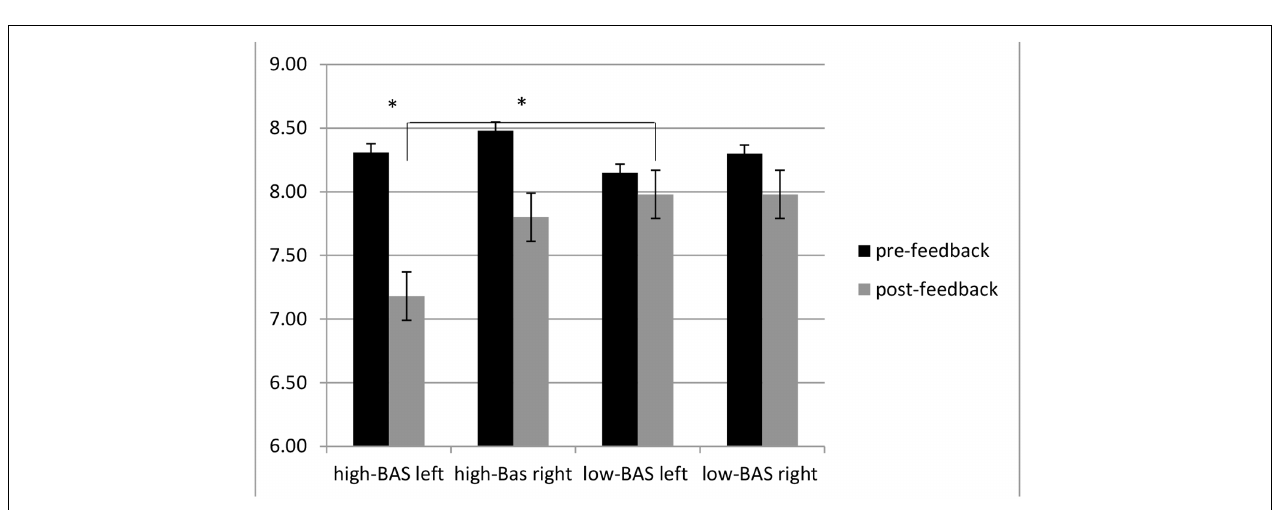
FIGURE 6 | Alpha band variation as a function of BAS and Condition. High-BAS showed increased left response in post-feedback than pre-feedback condition and compared to low-BAS in post-feedback condition. Asterisk indicates significant differences.